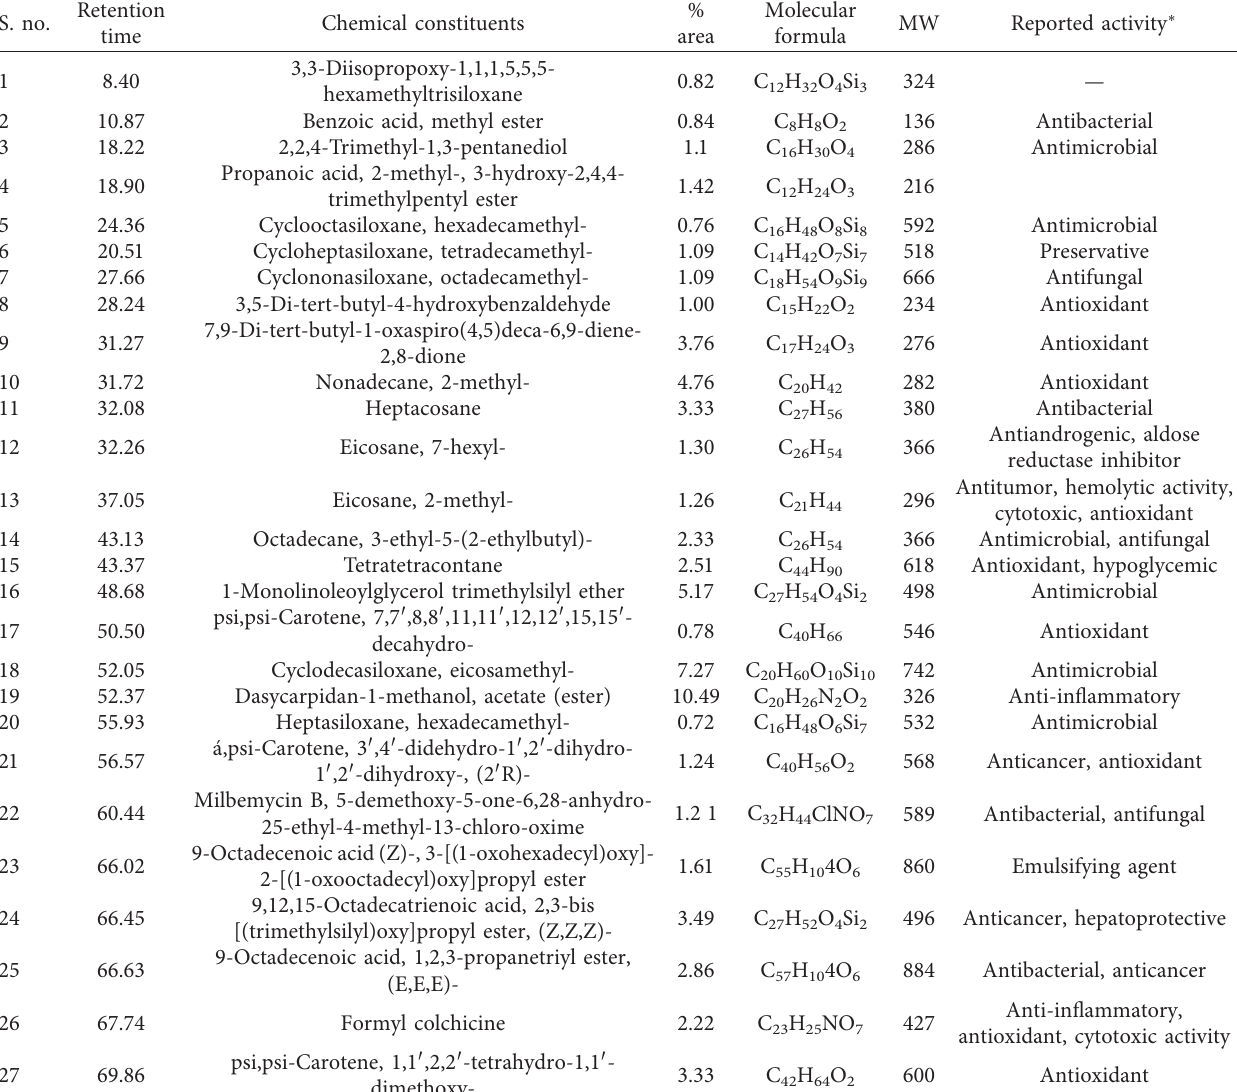
Table 1: GC-MS analysis of the ethanol extract of S. persica fruits.